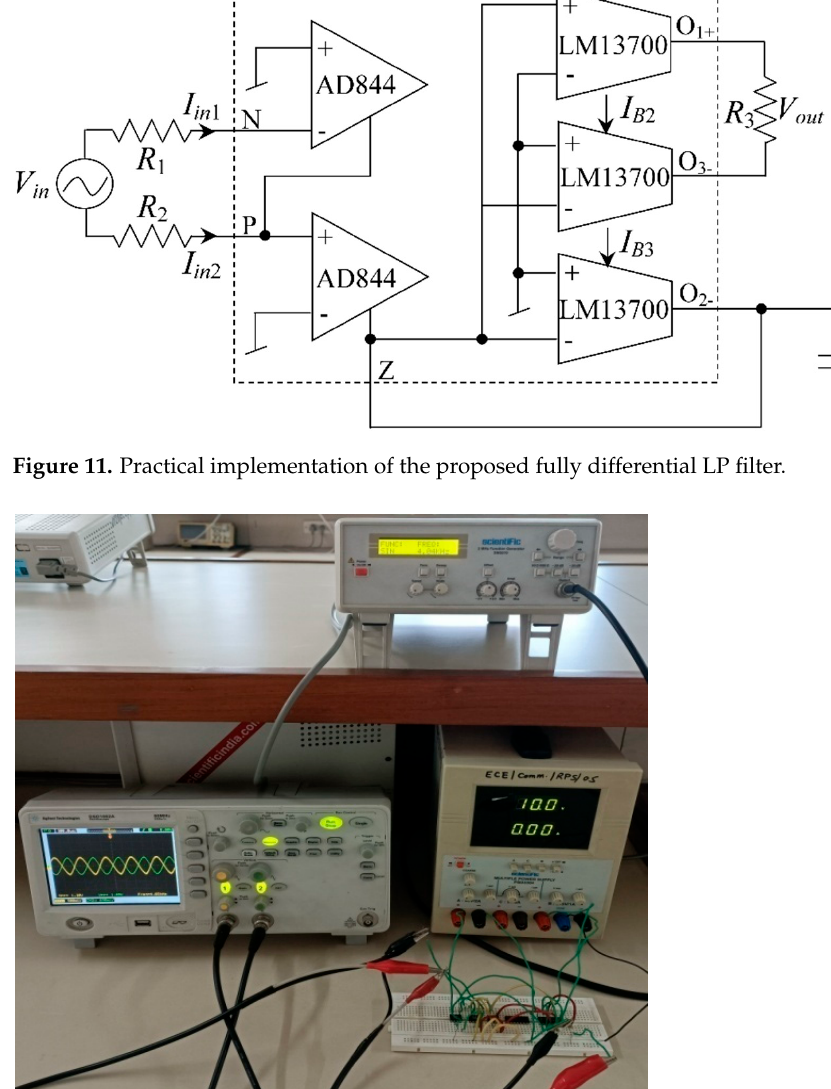
Figure 12. Experimental set-up using breadboard and discrete components.